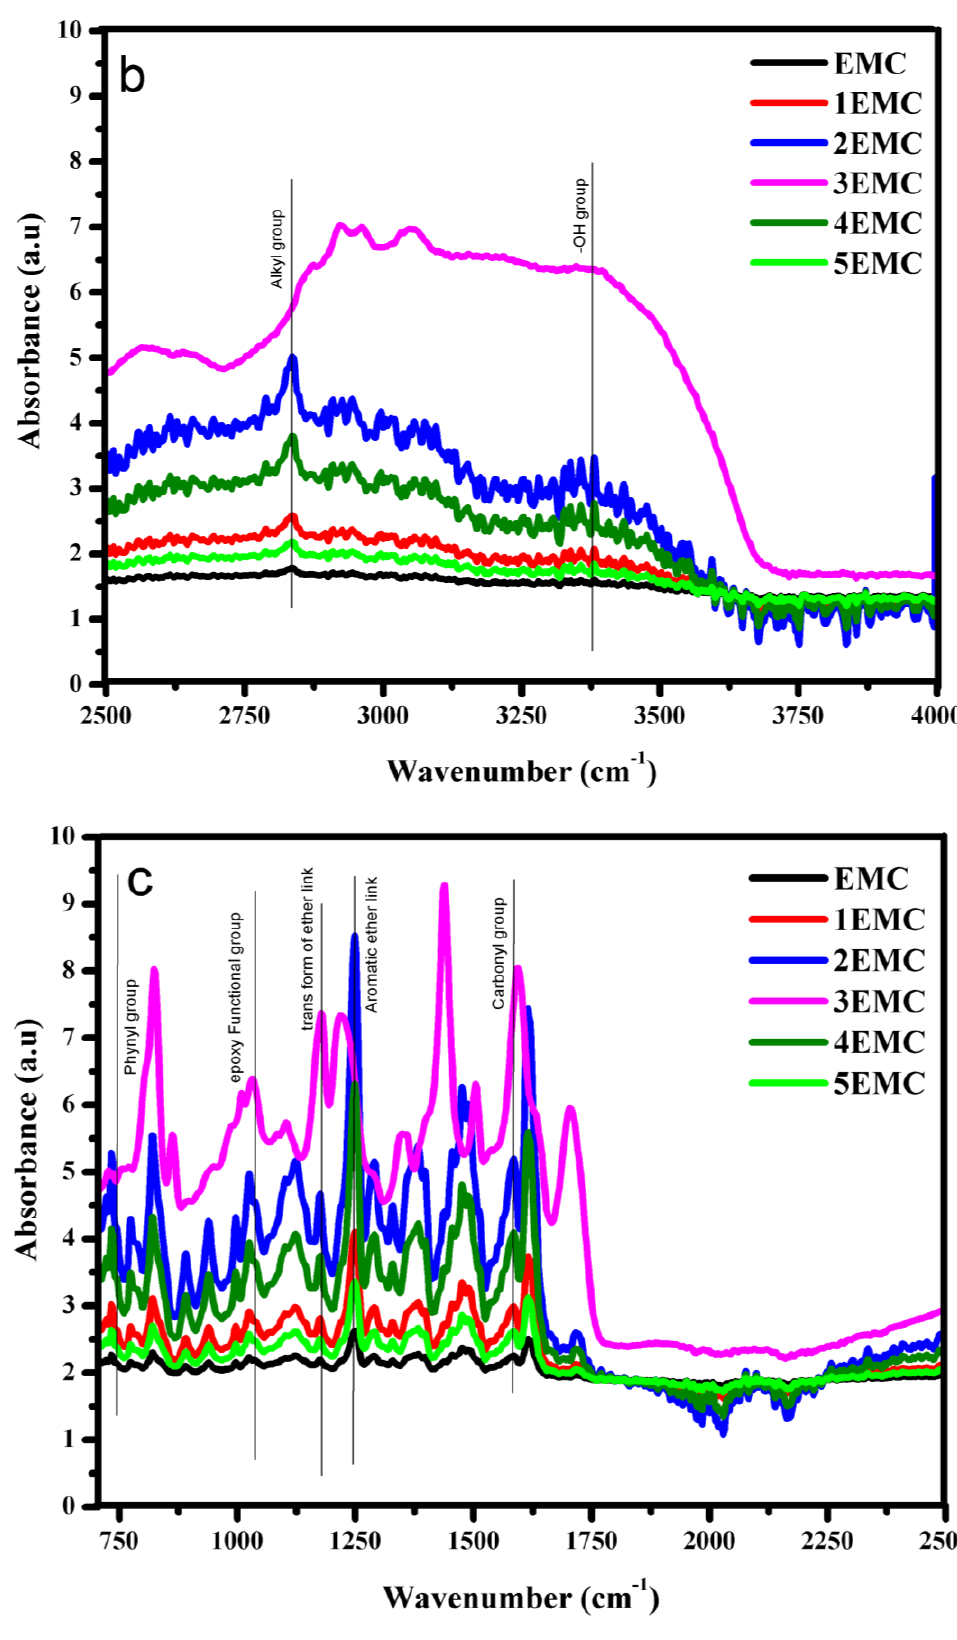
Figure 12. FTIR analysis epoxy microcomposite ( a ) unaged samples. ( b ) 30 h aged samples. ( c ) 60 h Figure aged samples.